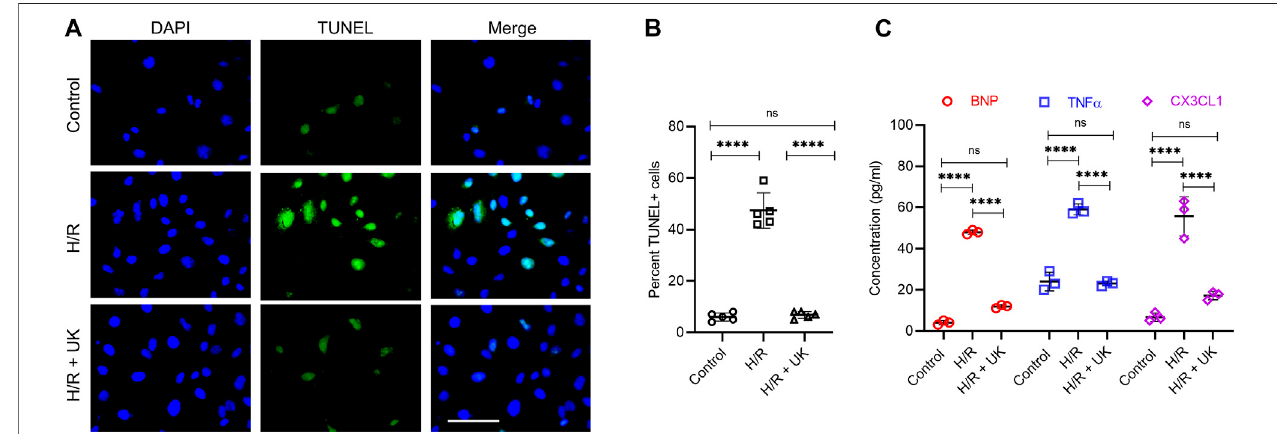
FIGURE 1 | Urokinase inhibits H/R-induced cell death and cytokine secretion. An in vitro model of APE in BEAS-2B cells. Cells were subjected to hypoxic conditions for12 hfollowed byreoxygenation for12 h(for details refer to Materials and Methods ). (A) Representative images from terminal deoxynucleotidyl transferase biotin-dUTP nick end labeling assay. (B) Graph shows quanti fi cation of images in (A) . Data are represented as mean ± SD; **** p < 0.0001, ns , not signi fi cant ( n = 5). (C) Secretion of indicated cytokines in the cell supernatant wasdetermined using Luminexassay. represented as mean ± SD; **** p < 0.0001, ns, not signi fi cant( n = 3) (UK: